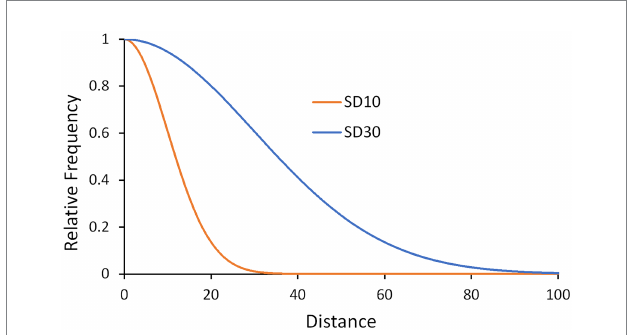
FIGURE 2 Example distributions of the relative frequency of dispersal distances for two of the five